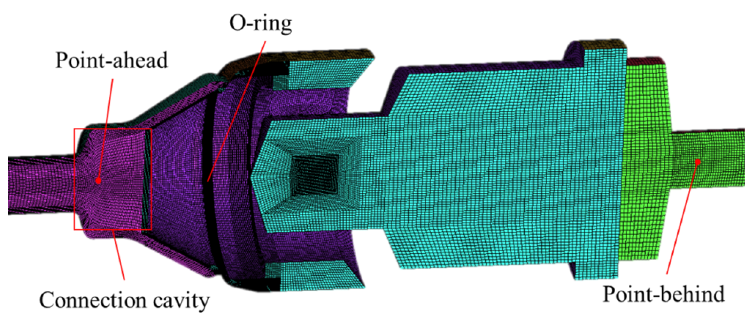
Figure 11. Location of two monitoring points and the connection cavity.